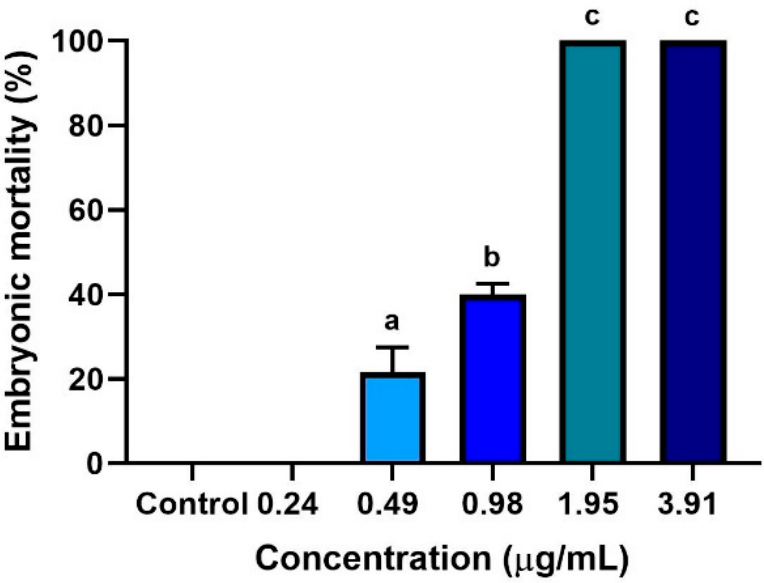
Figure 2. The embryotoxicity of different concentrations of ZO essential oil in embryonic zebrafish. Zebrafish embryos were treated with a series of twofold dilution concentrations (0.24–3.91 µg/mL). Percentages of embryonic mortality were calculated from embryo deaths after exposure to ZO essential oil at 0.24, 0.49, 0.98,1.95, 3.91 µg/mL, and 0.1% DMSO (control). Data represent the mean ± SD of three independent experiments ( n = 60 embryos/group). Experiments were analyzed using one-way ANOVA and Tukey’s multiple comparison test. Different lowercase letters indicate significant differences between groups ( p < 0.05).